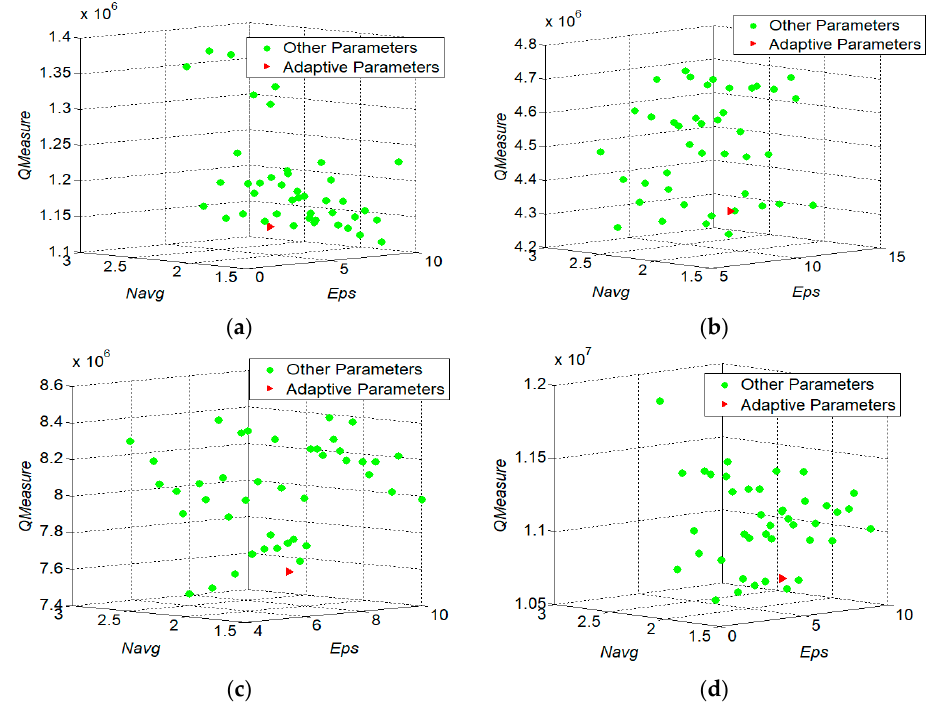
Figure 9. Experimental results of parameter adaptive analysis, ( a ) HT-100; ( b ) HT-200; ( c ) HT-300; and ( d ) HT-400.